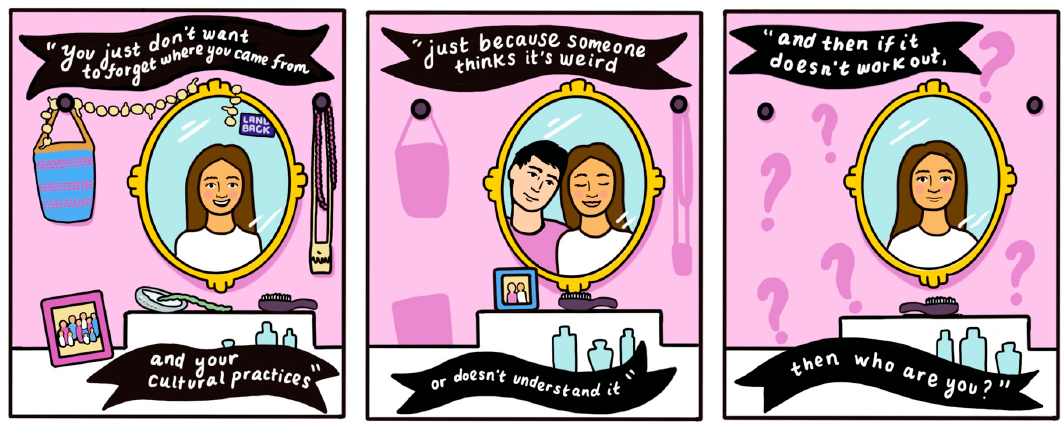
Figure 6. In the first panel a young woman is surrounded by items that represent her life as a Native person. In the second, a person she is dating appears and items that previously surrounded her are missing. In the final, the relationship is over and items representing who she was before the relationship have turned into question marks. See I.D. 6 in Appendix A.